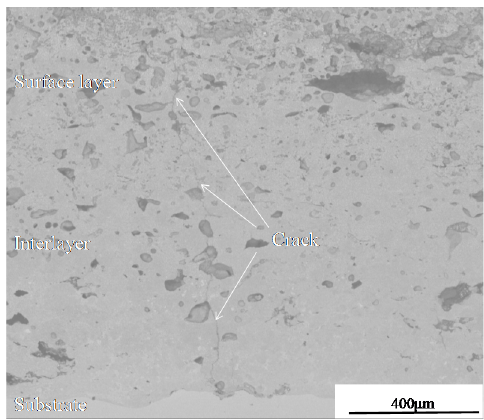
Figure 13. Micrograph of the cross ‐ section of the original coating after 600 thermal fatigue cycles.